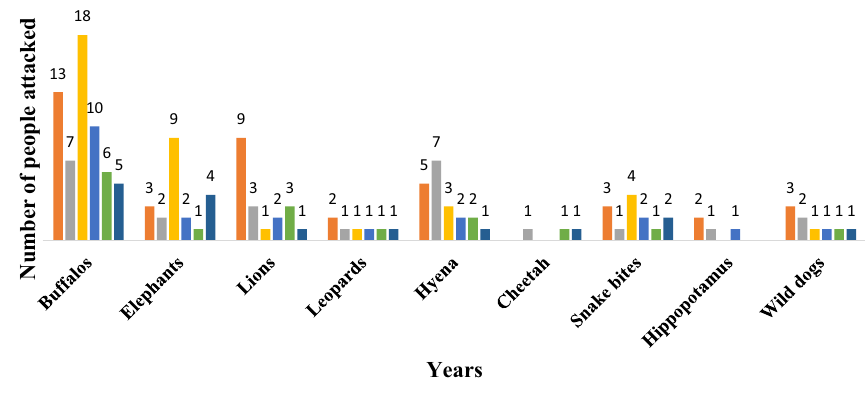
Fig. 6 Number of people hospitalized. Source: Demo- graphic Health Surveys